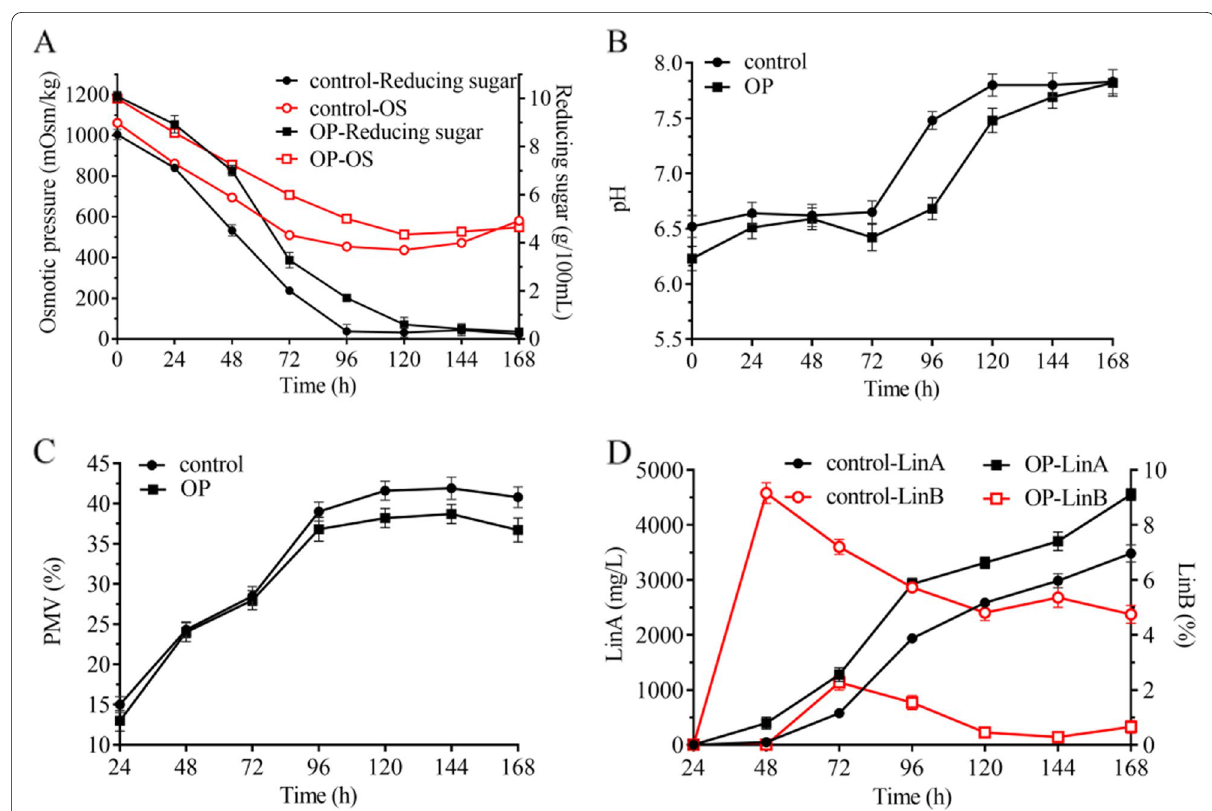
Fig. 3 Fermentation time‑course profile of Streptomyces lincolnensis grown in the optimized and the initial media. A Reducing sugar concentration and osmotic stress level during fermentation. B pH evolution. C PMV evolution; and D production of lincomycin A and lincomycin B in initial and optimized media. Control: initial medium; OP: optimized medium; OS: osmotic stress